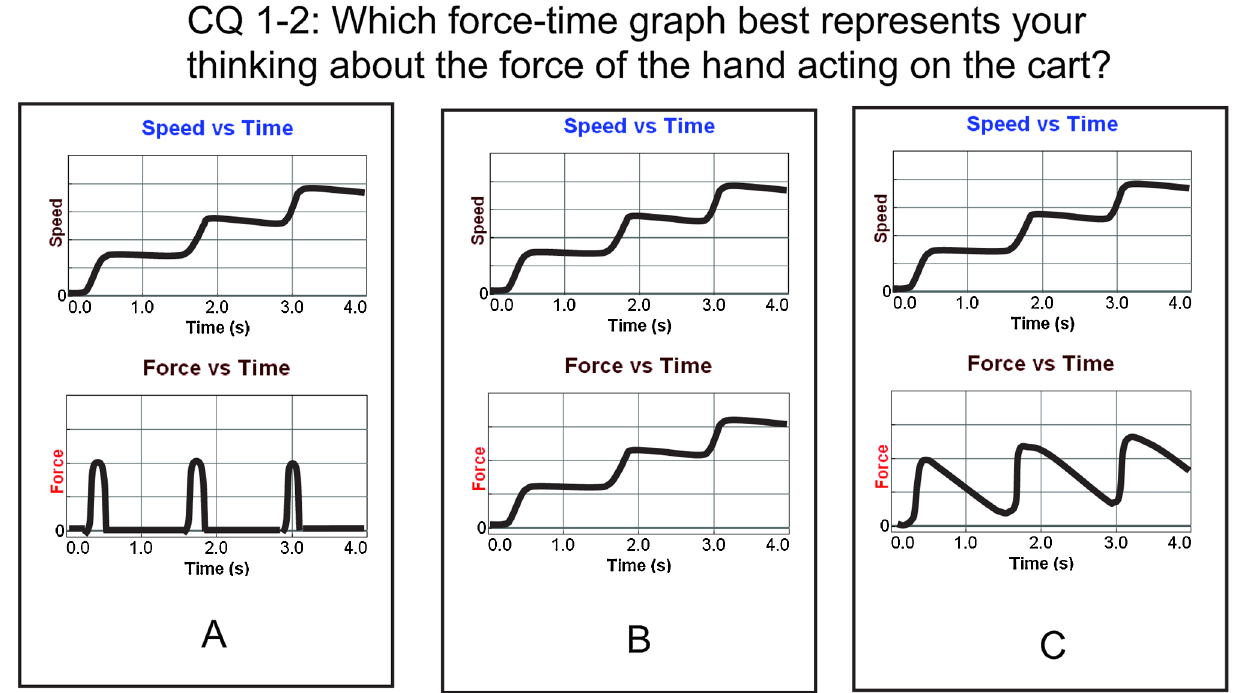
FIG. 7 (color online). Second clicker question in